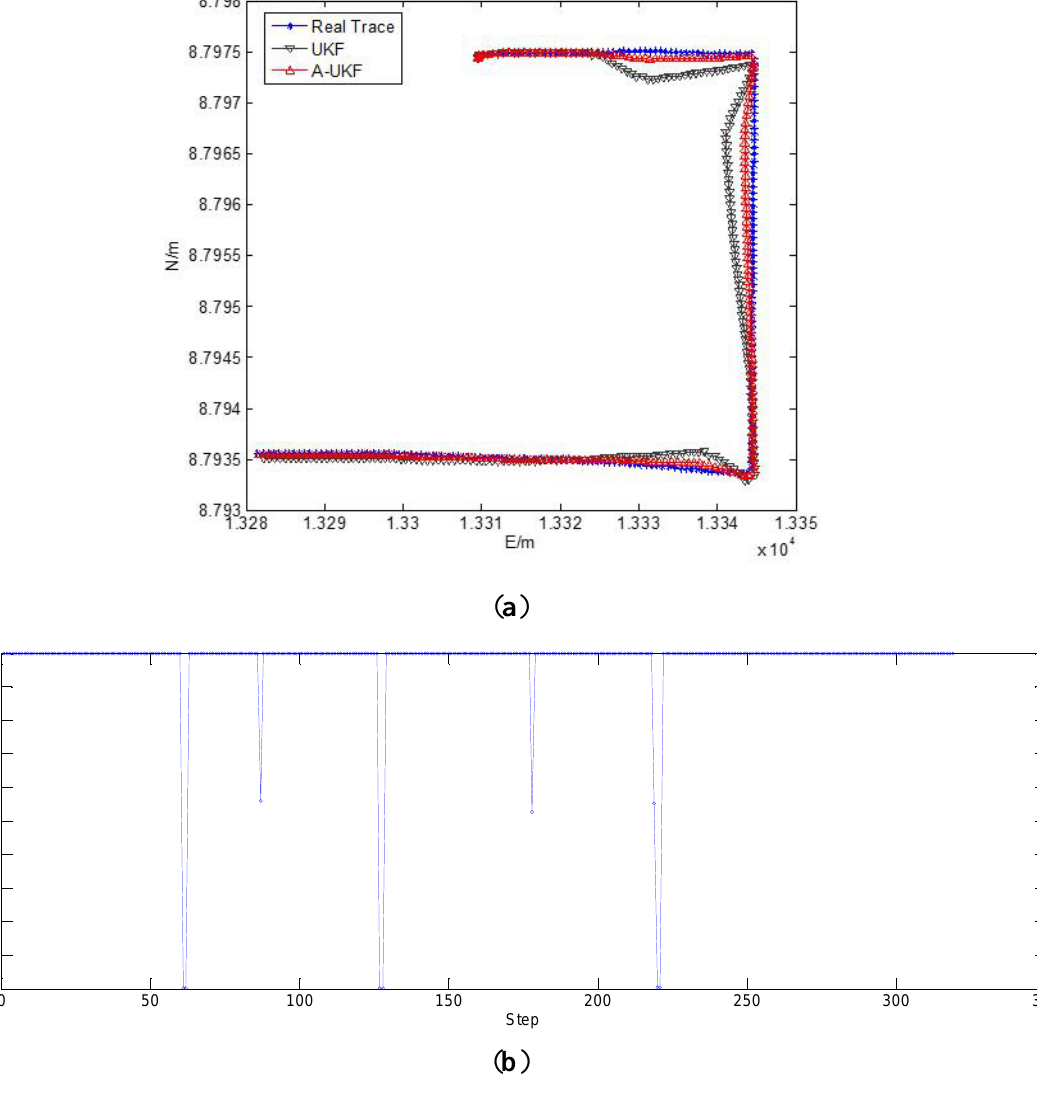
Figure 10. The results of the test: ( a ) estimated position based on Unscented Kalman Filter (UKF) and A-UKF and ( b ) variance of the adaptive